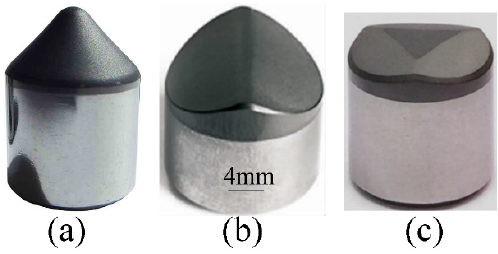
Figure 1. Illustration of non-planar cutters: ( a ) Conical cutter; ( b ) Axe cutter; ( c ) 3-RDE cutter.